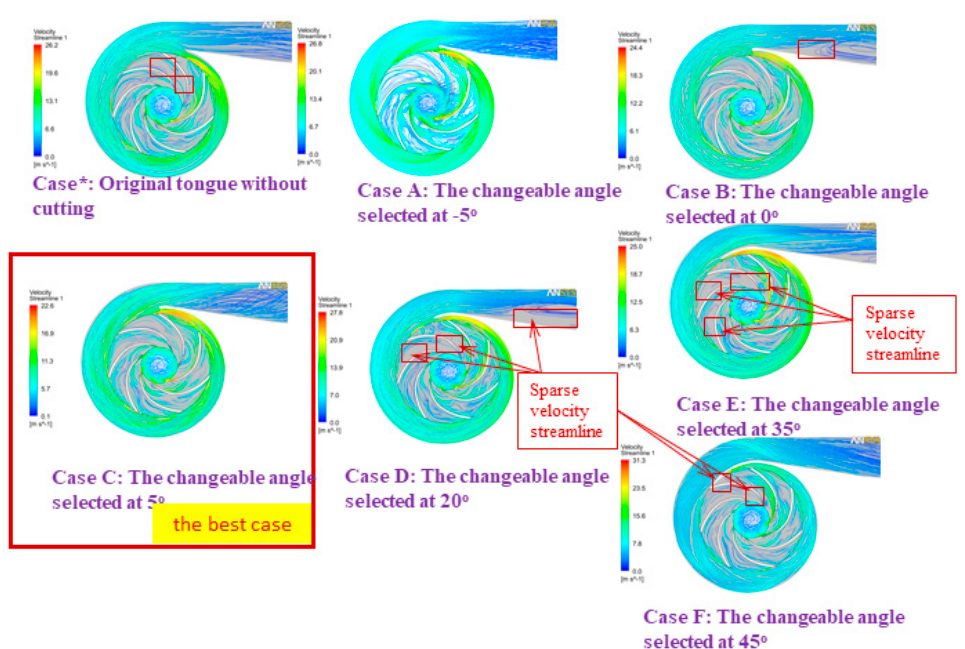
Figure 13. A comparison of the pressure spectrum of different angles.